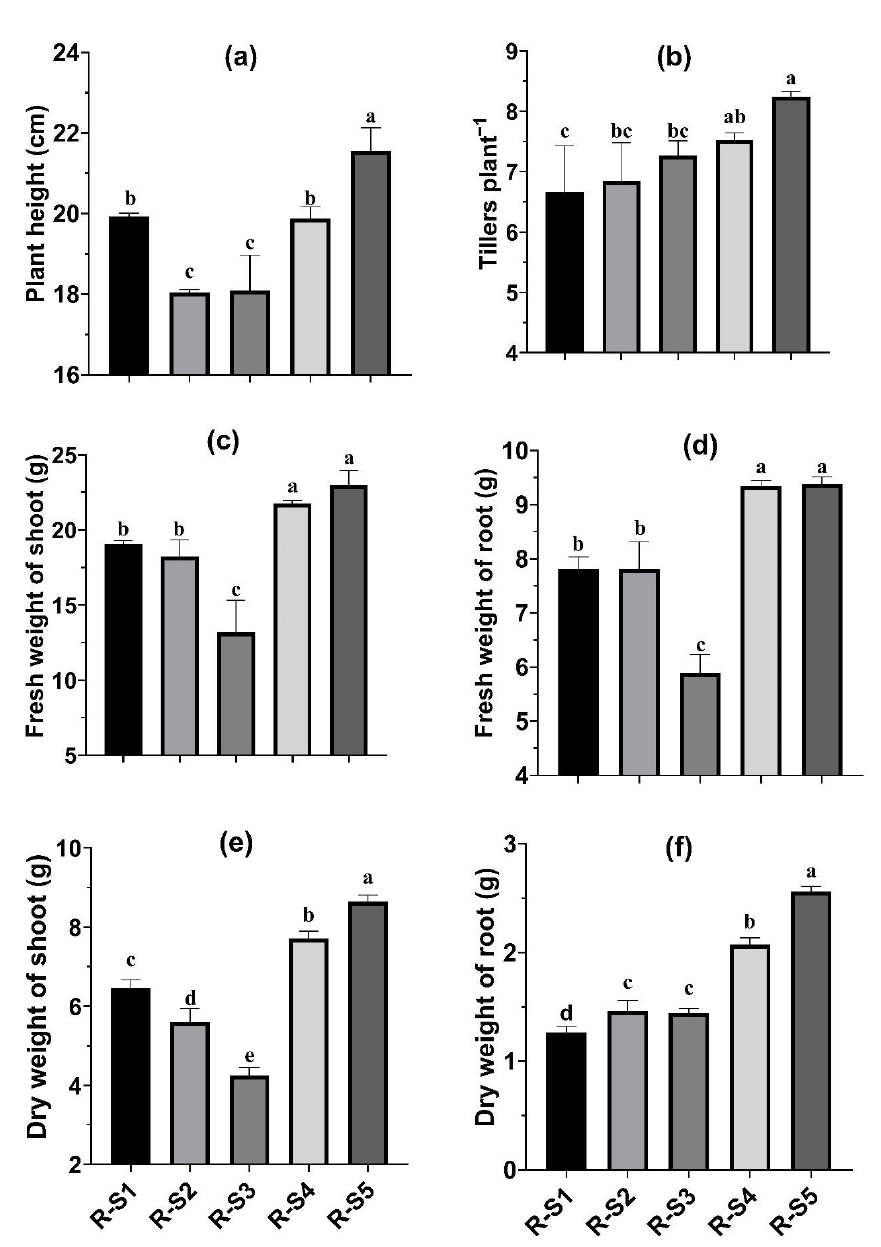
Figure 3. Growth parameters, i.e., plant height ( a ), tillers plant −1 ( b ), fresh weight of shoot ( c ), fresh weight of root ( d ), dry weight of shoot ( e ), dry weight of root ( f ) of Cenchrus ciliaris , as affected by the application of rhizospheric soils from selected plants. Each column with a different letter is significantly different at p < 0.05. Where R-S 1 = rhizospheric soil of Typha angustata , R-S 2 = rhizospheric soil of Cymbopogon jwarancusa , R-S 3 = rhizospheric soil of Saccharum spontaneum , R-S 4 = rhizospheric soil of Setaria verticillata , R-S 5 = rhizospheric soil of Saccharum bengalense